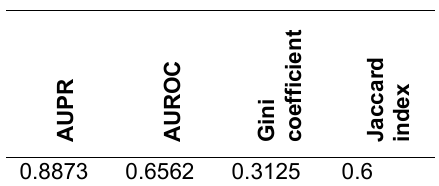
Table 3. Evaluation measures obtained for Naive